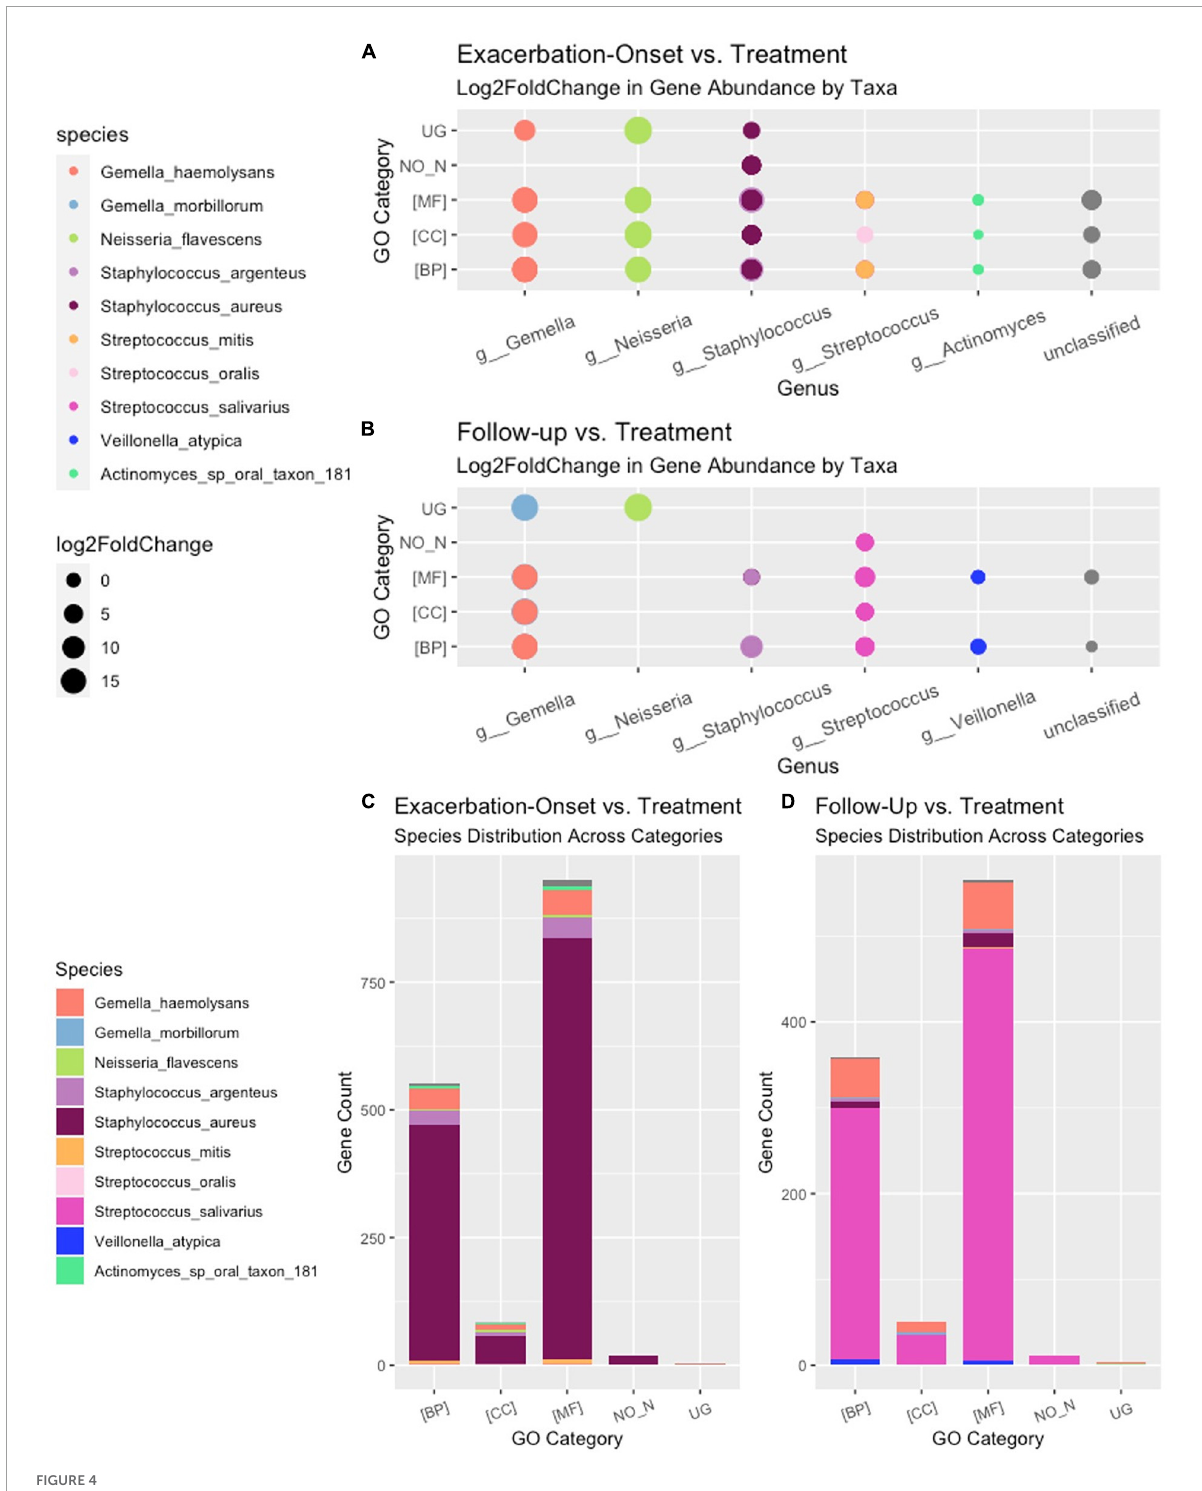
FIGURE4 Stratified differential abundance of bacterial genes between changes in clinical status. Panel (A) Log2 fold change distribution across bacterial species in Follow-up compared to Treatment across GO categories. Panel (B) Log2 fold change distribution across bacterial species in Exacerbation Onset vs. Treatment across GO categories. Panel (C) Stratified differential abundance of bacterial genes in Follow-up compared to Treatment across GO categories. Panel (D) Stratified differential abundance of bacterial genes in Exacerbation-Onset compared to treatment across GO categories. GO, gene ontology; BP, biological processes; MF, molecular functions; CC, cellular components. The genus name is centered on each column